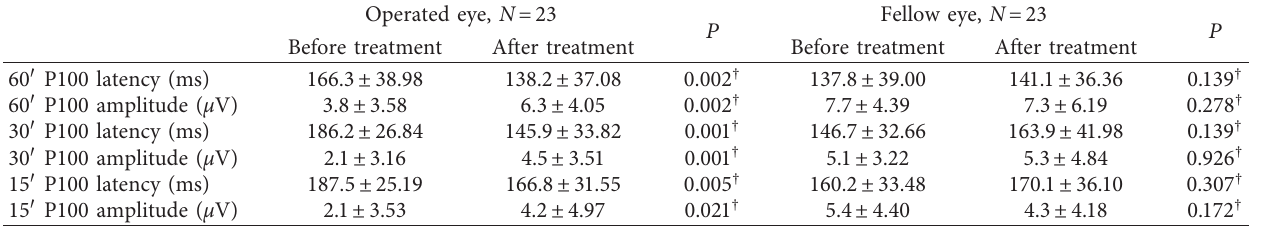
Table 6: Visual evoked potential parameters of the operated eyes and fellow eyes in patients with bilateral DON before and after treatment. Operated eye, N � 23 Fellow eye, N � 23 P P Before treatment After treatment Before treatment After treatment